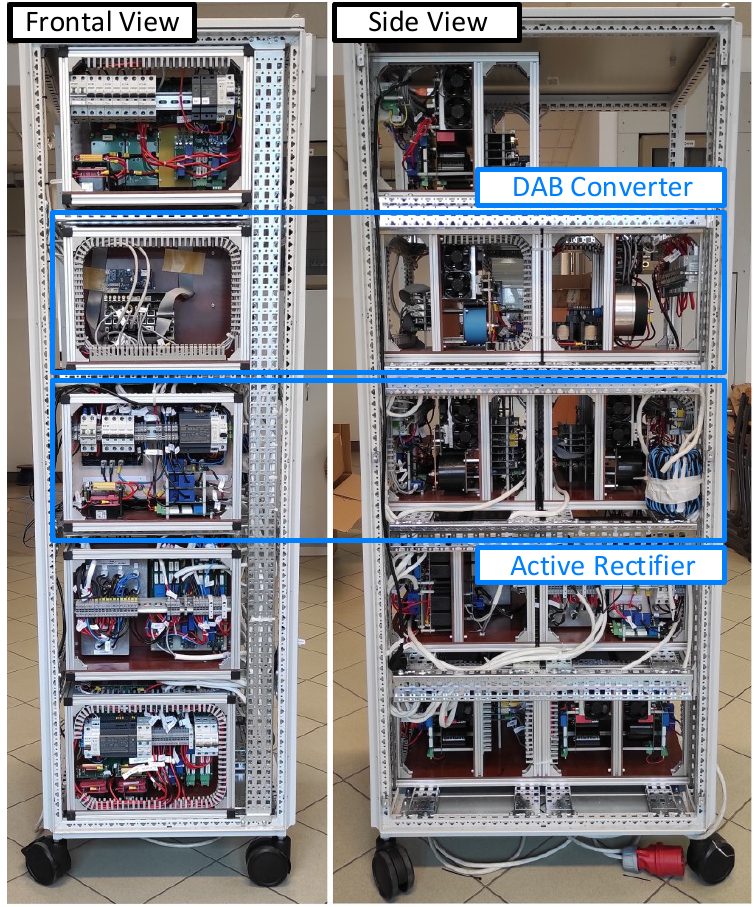
Figure 14. View of the rack, in which the DAB converter and active rectifier are installed. In the scenario used for the tests presented here, the DAB converter is supplied at the input side from an active rectifier, which regulates a constant DC voltage. The output side of the DAB converter is connected to a passive resistive load via a